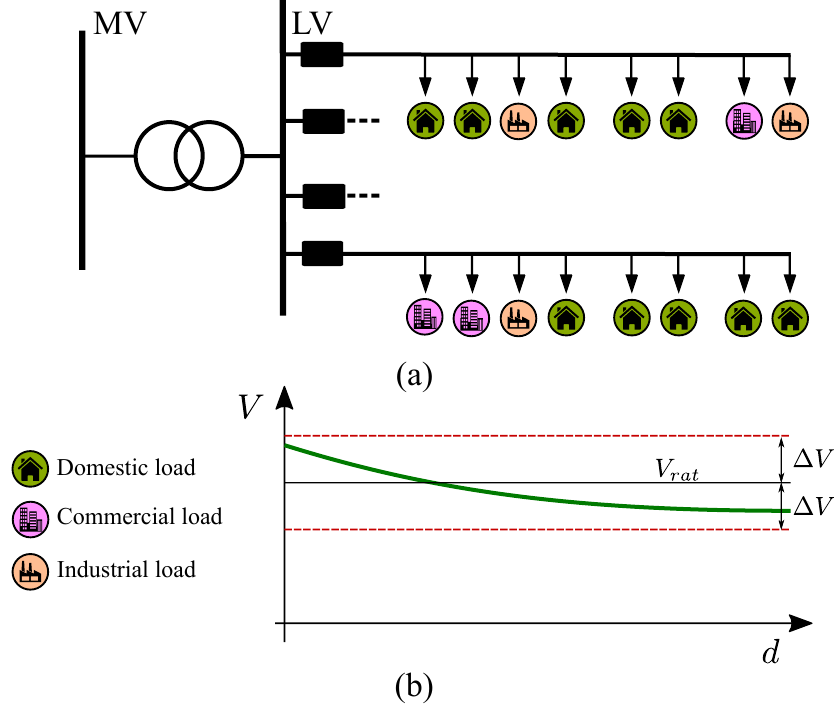
Figure 1. One-way LV distribution feeders: ( a ) one-line diagram; and ( b ) voltage profile along the